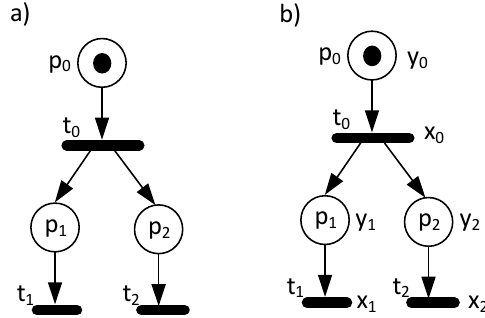
Figure 2. A sample Petri net with concurrent processes ( a ), and additionally with guards ( b ).